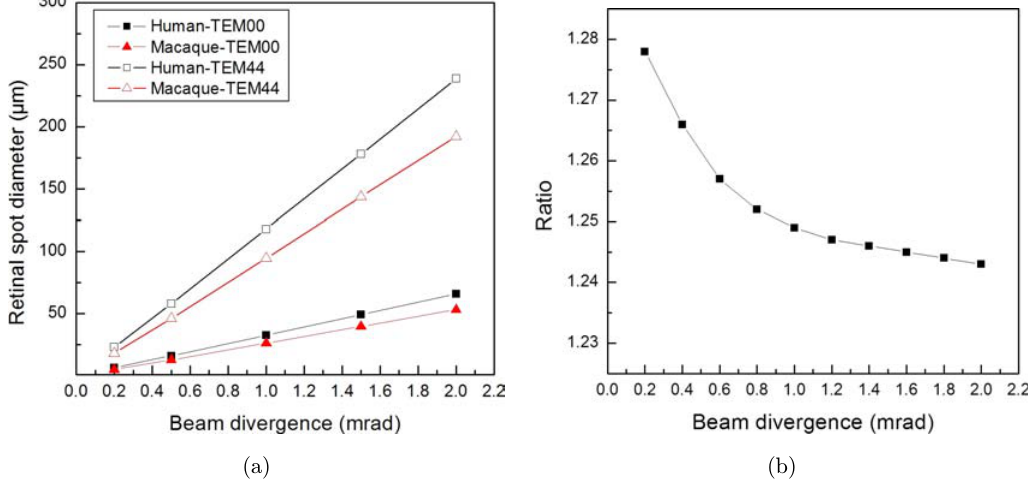
Fig. 8. Retinal spot diameter of TEM 00 and TEM 44 mode versus beam divergence of the embedded TEM 00 mode for human and macaque (a) and the ratio between the two species